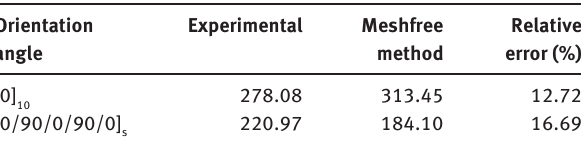
Table 4 Comparison to the critical energy release rate ( G , N/m) for carbon/epoxy laminate (AS4/3501-6) in mode II.